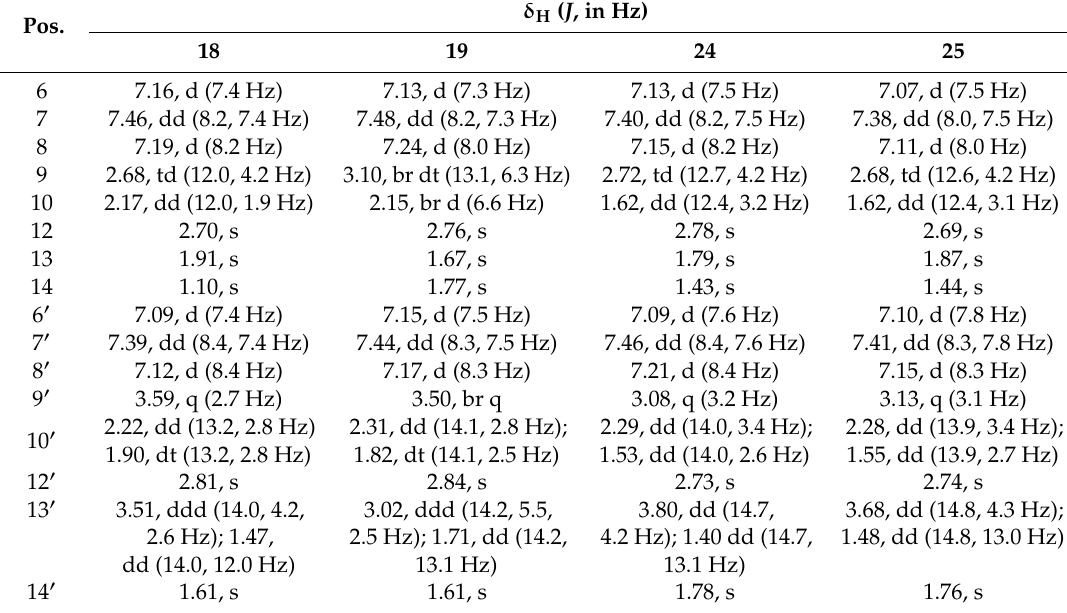
a NMR data obtained with samples in methanol- d